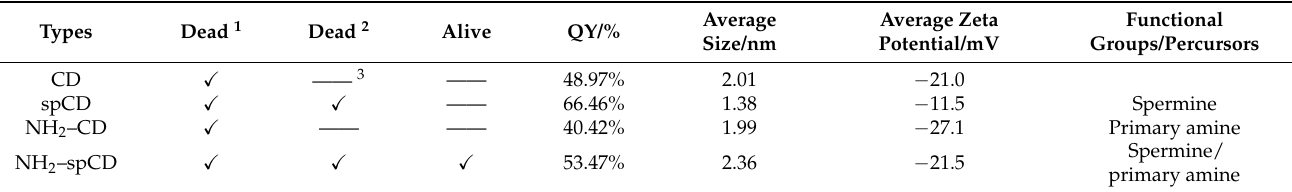
Table 1. A summary for the four types of